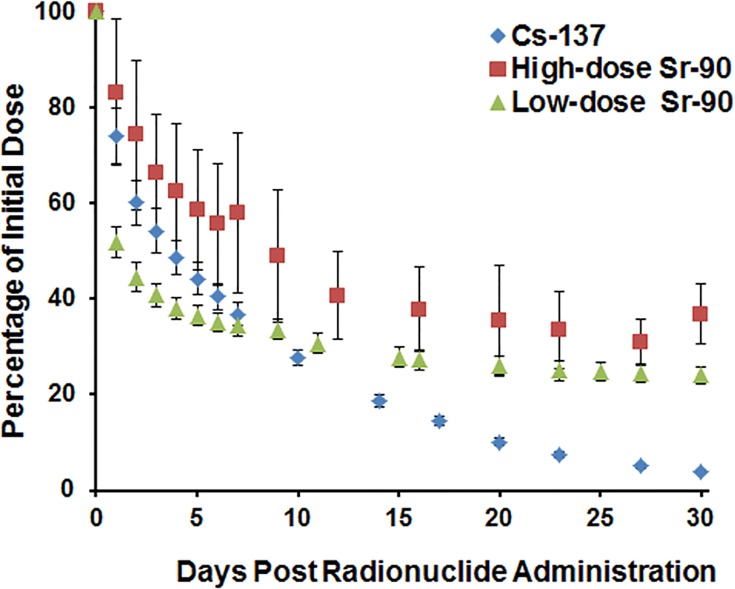
Retention profiles for 137CsCl and 90SrCl2.